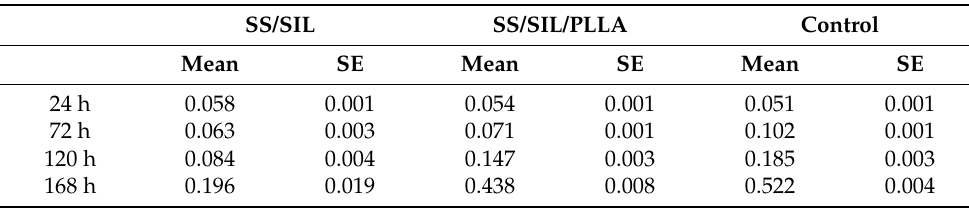
Figure 2. Cytocompatibility assessed by the Presto Blue™ viability assay for hDPSCs. Results are presented in mean ± SE (standard error of the mean). Differences were considered statistically significant at p < 0.05. Results significance are pre- sented through the symbol (*), according to the p -value, with one, two, three or four symbols, corresponding to 0.01 ≤ p < 0.05; 0.001 ≤ p < 0.01; 0.0001 ≤ p < 0.001, and p < 0.0001, respectively. Table 1. Cytocompatibility assessed by the Presto Blue™ viability assay for hDPSCs. Corrected absorbance results are presented in mean ± SE.